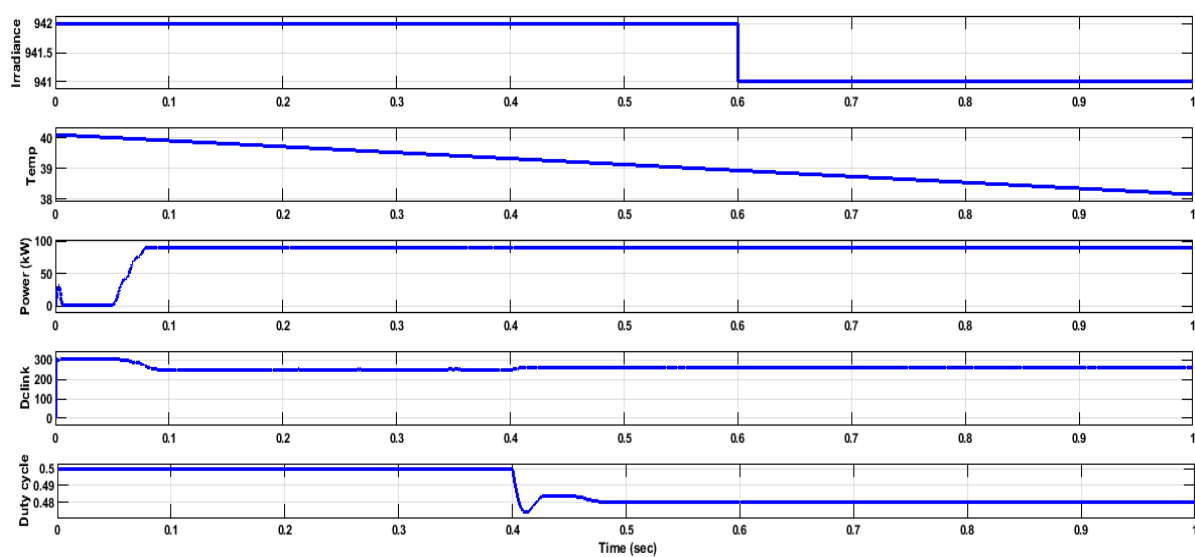
Figure 10. Performance analysis using the ANN–AOA method.